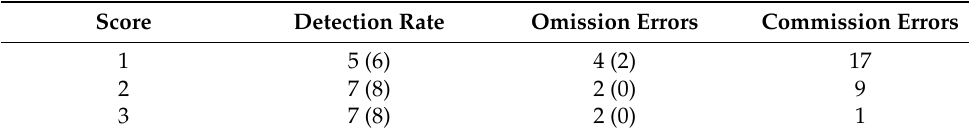
Table 2. Detection rate, errors of omission and commission errors for rock walls (>250 m 2 ) with different score values compared to ground reference data (rock walls). The numbers in the parenthesis are presented with the corrected field reference data.